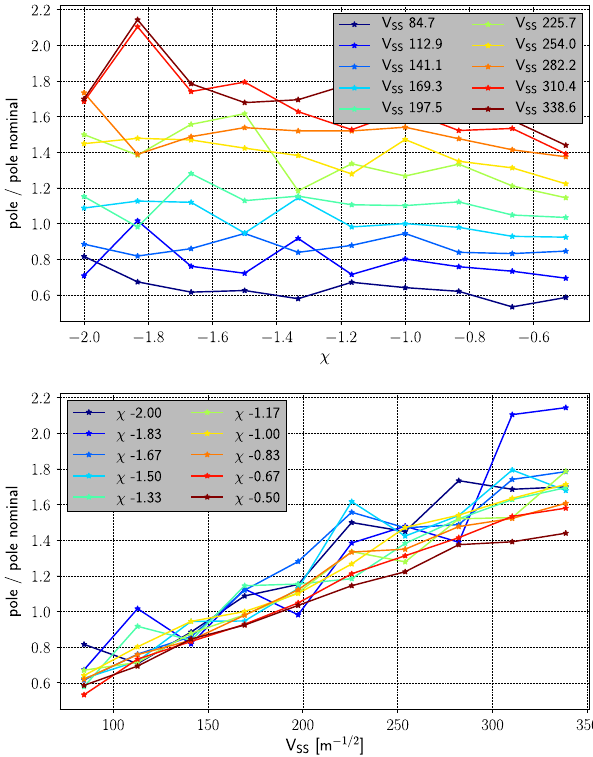
FIG. 19. 1D projections of the transfer function pole, normal- ized to the one of the nominal SPS working point. Top: fixed V curves as a function of χ . Bottom: fixed χ curves as a function of V ss